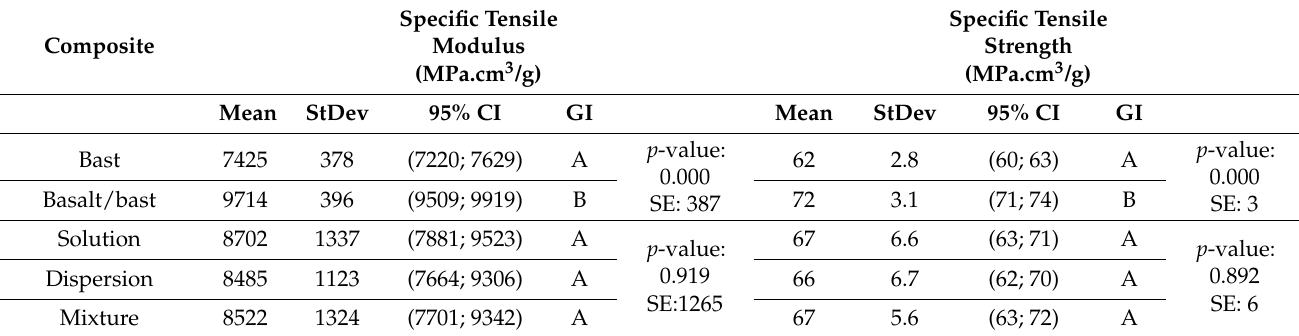
Table 8. Comparison of the equality of means using one way analysis of variance—specific tensile analysis.